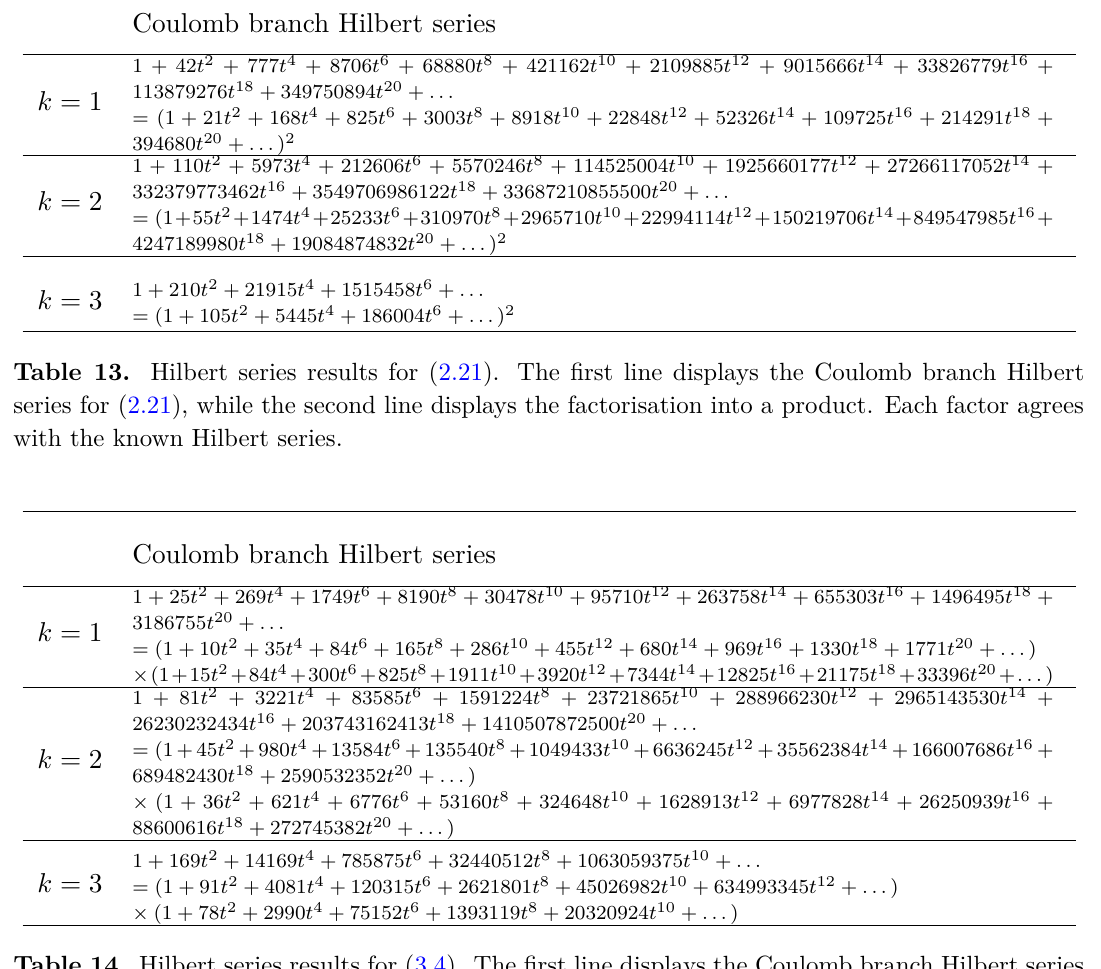
Table 14. Hilbert series results for (3.4). The first line displays the Coulomb branch Hilbert series for (3.4), while the second line displays the factorisation into a product. Each factor agrees with the known Hilbert series for O so (4 k +1) and O so (4 k +2) , (2 2 k , 1 1 ) (2 2 k , 1 2 )